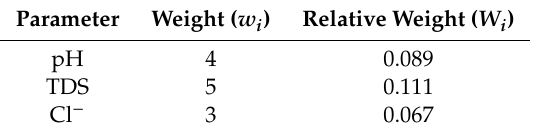
Table 3. Weights and relative weights of the parameters to evaluate the water quality